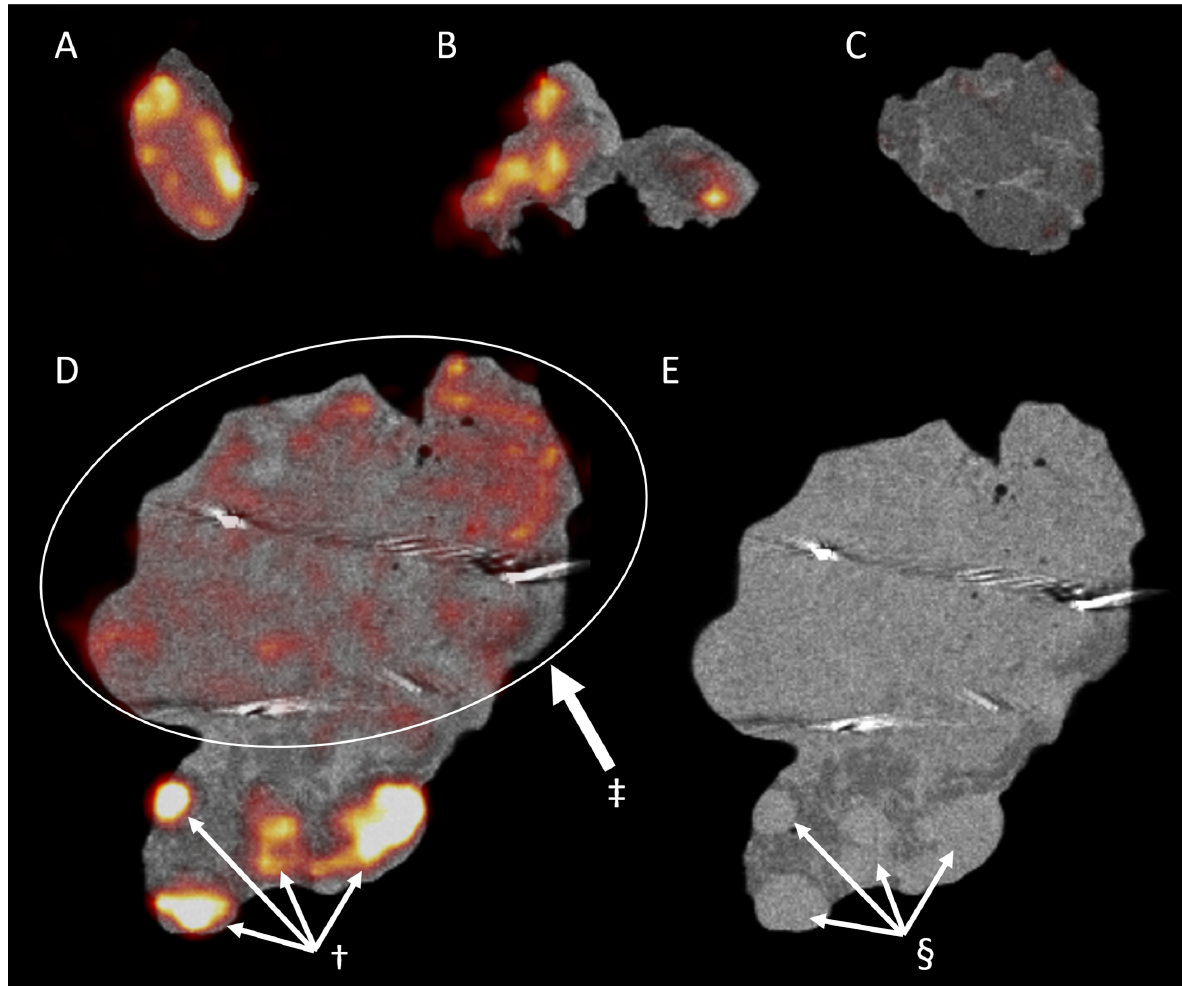
Figure 5. PET and CT-imaging of the resected lymph nodes. A and B display the ambiguous 18 F-FDG uptake of non- malignant lymph nodes in contrast to C that eventually led out to be fatty tissue and could hence be used as a negative control. ( D , E ) display the PET/CT and CT-imaging, respectively, of the resected region 1a during neck dissection. These images display the presence of (non-malignant) lymph nodes both on PET (†) and CT (§). Moreover, ‡ displays the physiological 18 F-FDG uptake in the submandibular salivary gland ( A ): Negative sentinel lymph node of patient 1. ( B ): Two negative sentinel lymph nodes of patient 1. ( C ): Fatty tissue that was resected during sentinel procedure in patient 1. ( D ): PET/CT imaging of the anatomical neck region 1a resected during lymphadenectomy from patient 2. ( E ): CT-imaging of anatomical neck region 1a resected during lymphadenectomy from patient 2.